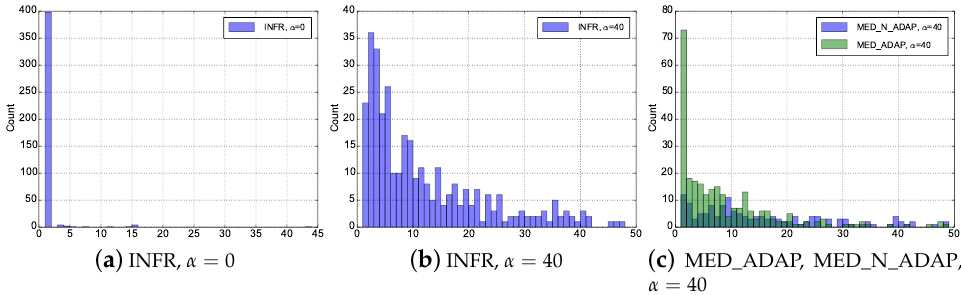
Figure 5. Distribution of the number of sent